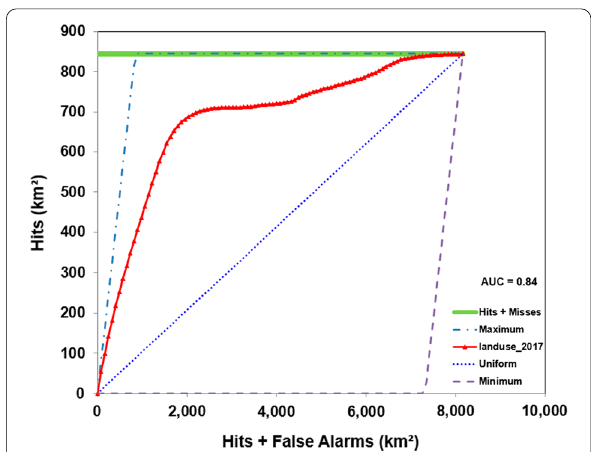
Fig. 7 The area under the curve of the total operating characteristic showcasing the validation of the model